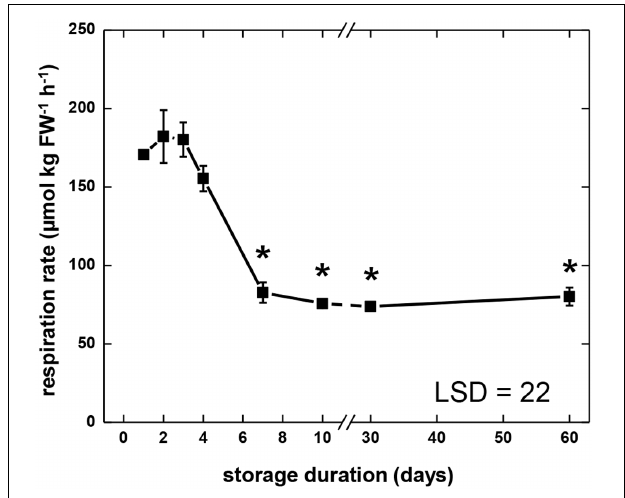
FIGURE 1 | Respiration rate of sugarbeet roots during 60 days of storage. Freshly harvested roots were stored for 10 days at 10 ◦ C and 90 ± 5% relative humidity (RH), then stored at 4 ◦ C, 90 ± 5% RH for 50 days. Respiration rate of individual roots was measured as CO 2 produced at 10 ◦ C per kg fresh weight per hour. For measurements at 30 and 60 days, roots were equilibrated for 2 days at 10 ◦ C prior to measurement. Error bars are ± 1 standard error of the mean, where n = 7. Asterisks denote data that are significantly different from the initial respiration rate, with α = 0.05.